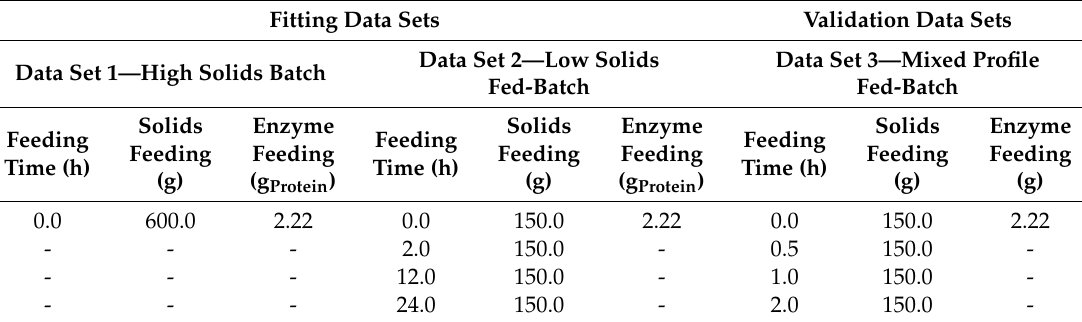
Table 1. Data sets feeding